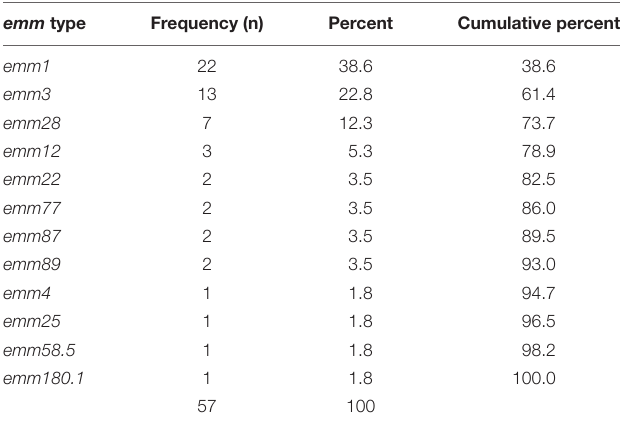
TABLE 2 | Distribution of emm types.